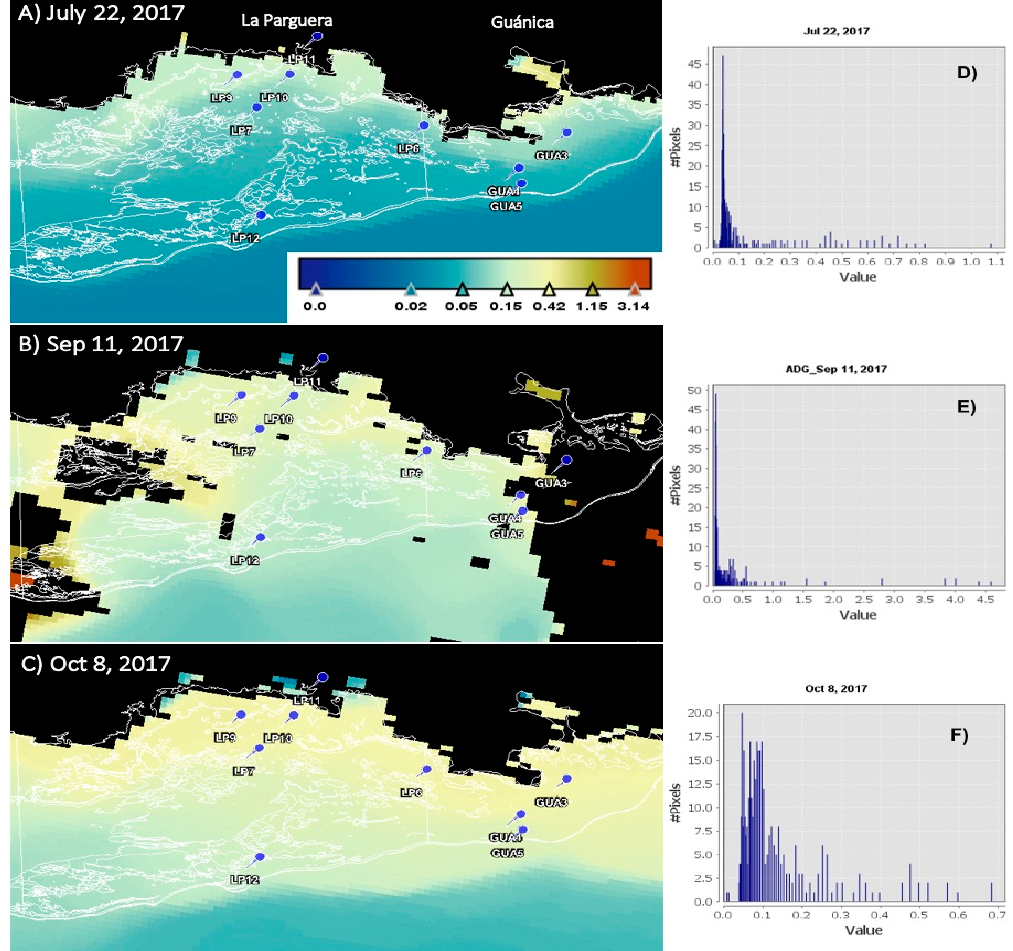
Figure 4. Sentinel 3A ADG_443_NN product (median visualization). Contour lines represent coral reefs as the region of interest (ROI) while the perpendicular lines represent the limits of La Parguera Natural Reserve. Black areas represent land-mask and cloud-mask applied to the imagery ( A ) before the hurricanes on 22 Jul 2017 ( B ) 11 Sep 2017 after Hurricane Irma and ( C ) Oct 8, 2017 after two hurricane events (H. Irma and H. Mar í a); ( D ) Histograms for regions of interest representing ADG443_NN pixel values on 22 July 2017, ( E ) 11 September 2017 and ( F ) 8 October